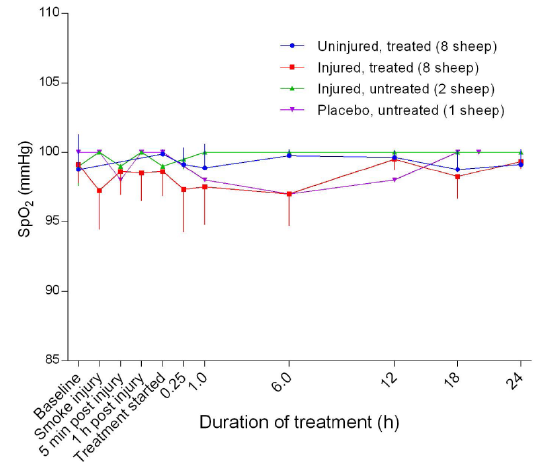
Figure 3. Arterial oxyhaemoglobin saturation (SpO ± SD) in smoke and non-smoke injured sheep that received extracorporeal life support as compared to that in untreated controls. Error bars are one-sided for clarity.